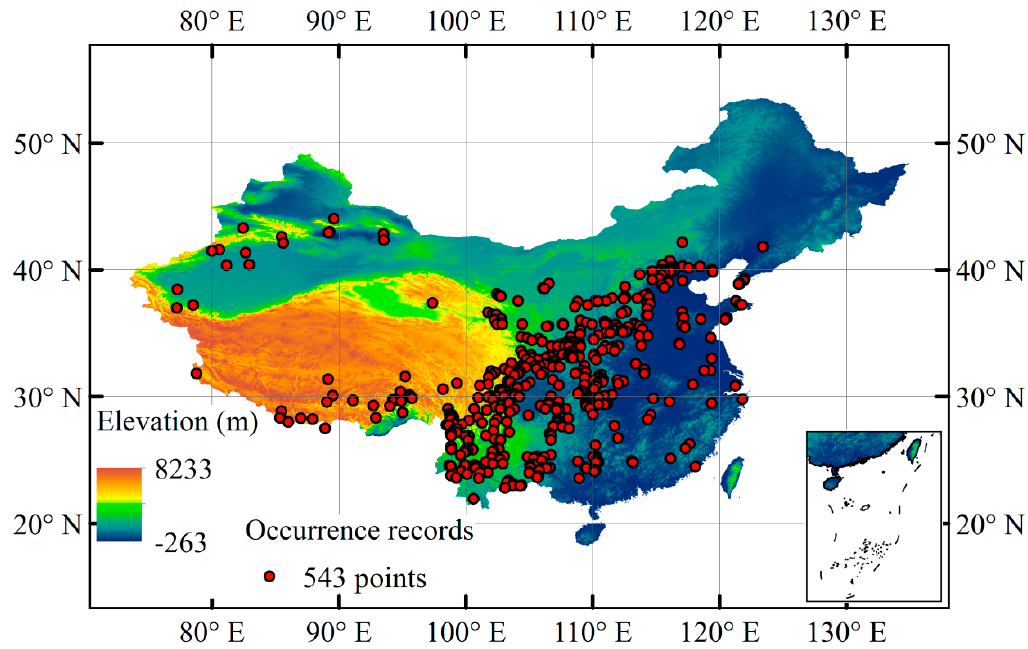
Figure 1. Spatial distribution of occurrence records of Juglans regia and elevation in China.